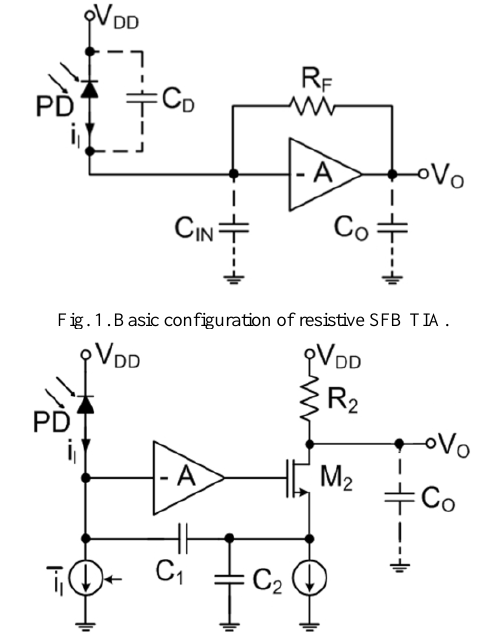
Fig. 2. Concept of capacitive feedback